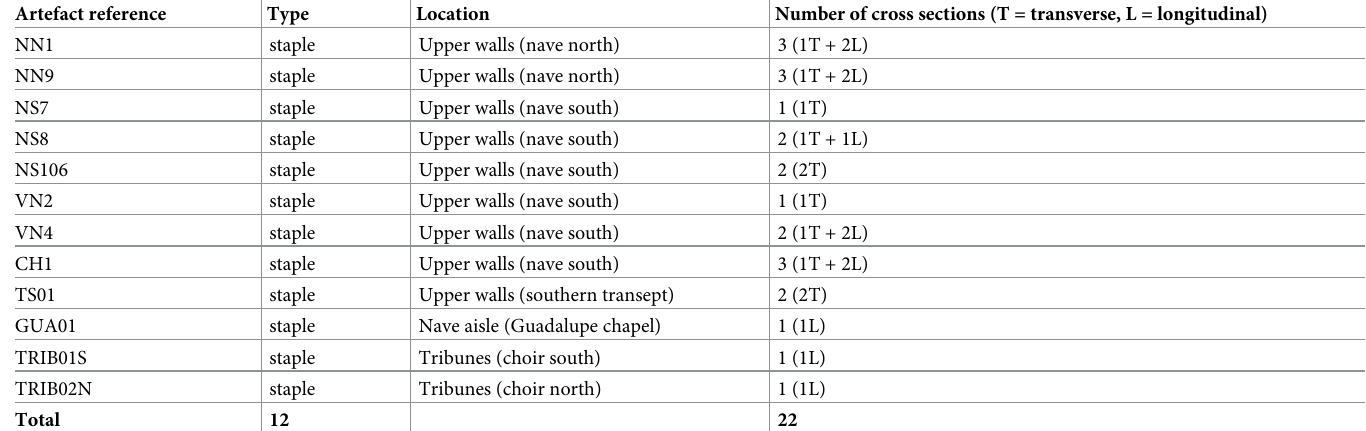
Table 1. List of studied artefacts and samples. Artefact reference